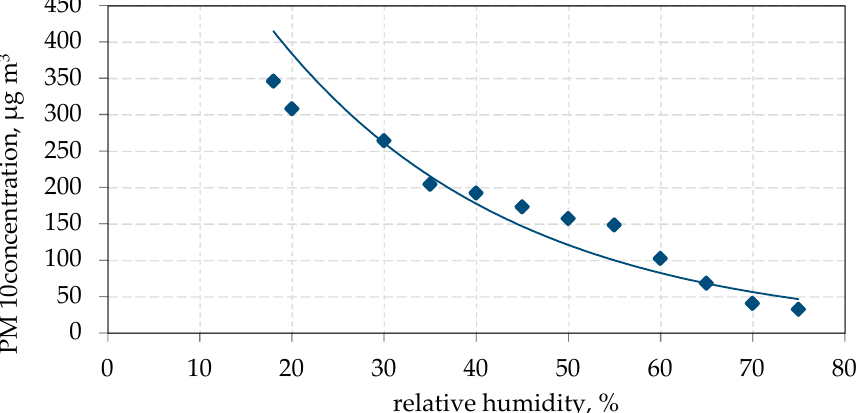
Figure 11. PM 10 concentration measured by the PM probe, collected and processed in relation to the relative humidity in August 2022.